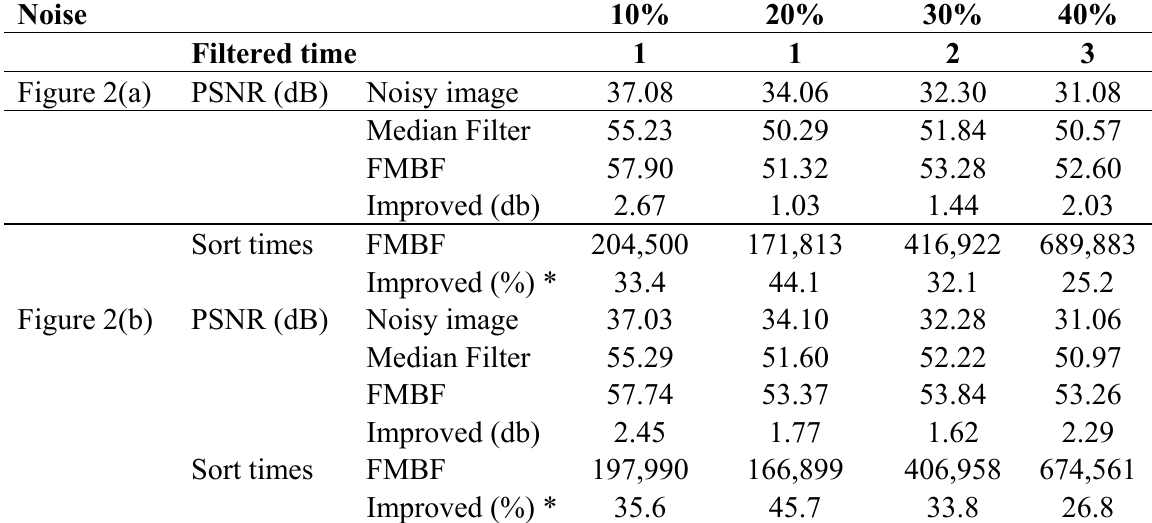
Table 1. The improved performances of the images processed by